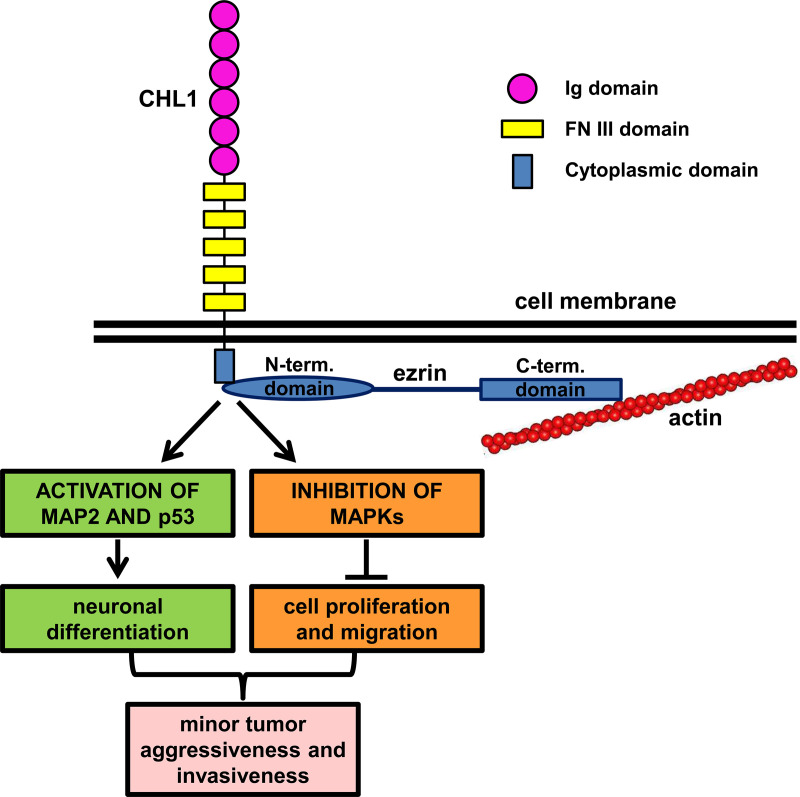
Schematic model of proposed CHL1-ezrin signaling in NB cells.The intra-cytoplasmic CHL1 C-terminal domain interacts with the N-terminal domain of ezrin, which links cytoskeletal actin through its C-terminal domain. This molecular binding activates MAP2 and p53 pathways and inhibits MAPK phosphorylation, inducing neuronal differentiation rather than cell proliferation and migration, thus conferring less aggressive features on NB (The CHL1 extracellular portion contains six Immunoglobulin (Ig)-like domains and five Fibronectin (FN) type III domains).